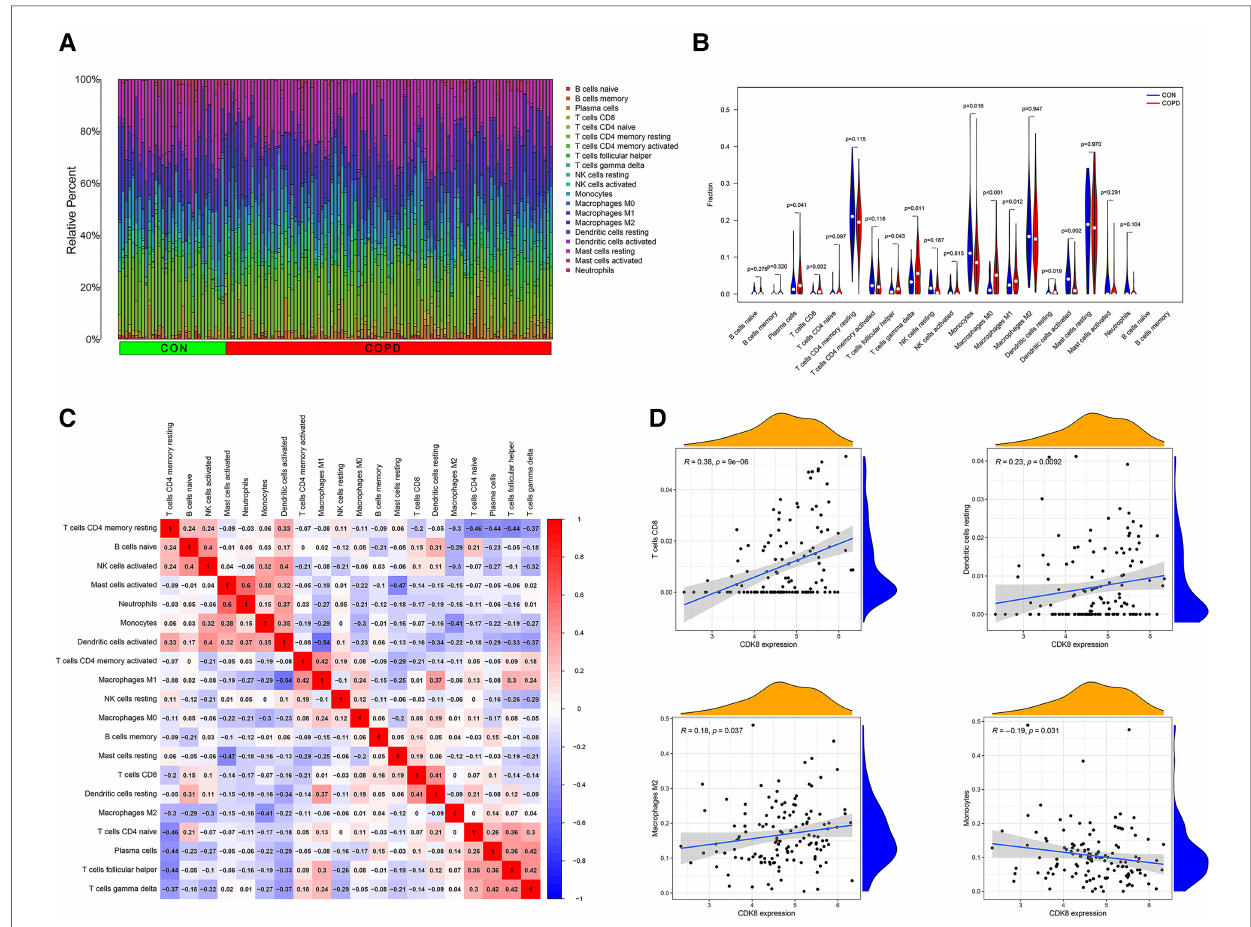
FIGURE 8 Immune cell in fi ltration analysis of GSE76925 and immune cell correlation analysis of CDK8. ( A ) The proportion of immune cells in different samples. ( B ) Comparison of immune cell ratios in the COPD and control groups. ( C ) Heat map of correlation analysis between immune cells. ( D ) Analysis of the correlation between CDK8 and immune